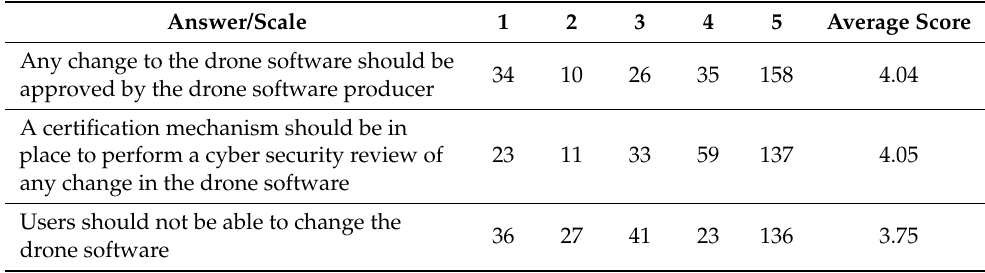
Table 4. Preventive measures, software changed by